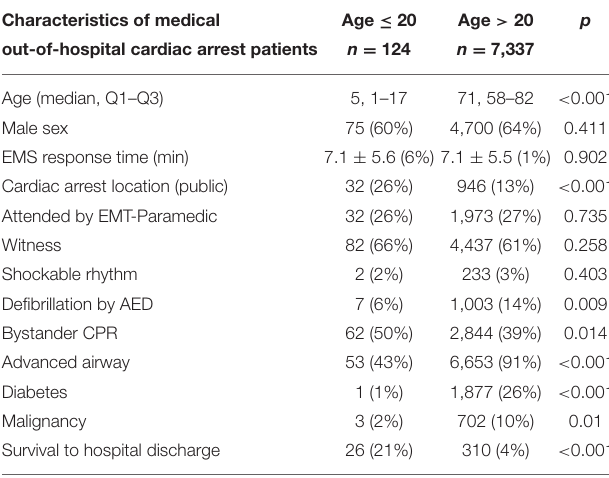
TABLE 1 | Demographic factors and outcome among pediatric and adult patients of out-of-hospital cardiac arrest patients. Characteristics of